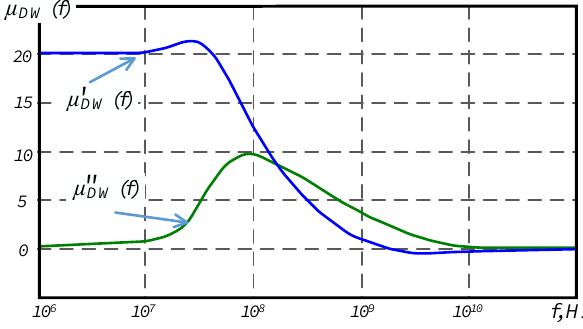
Fig. 12. KKR evaluation of DW component of the measured [7] CIP spectrum.